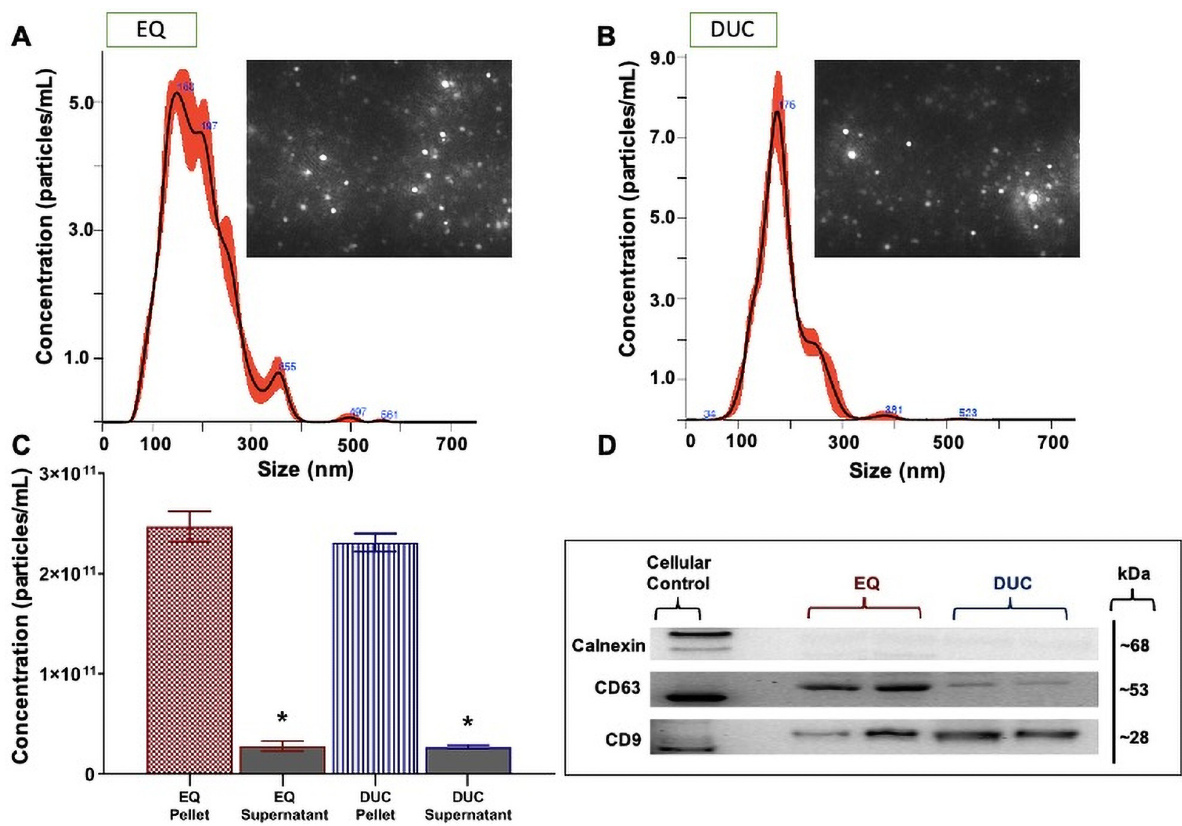
Fig 9. Human milk-derived exosomes isolated via ExoQuick (EQ) precipitation and differential ultracentrifugation (DUC) method. Size and distribution profiles of human milk-derived exosomes as determined by Nanoparticle Tracking Analysis (NTA) (A). Concentration [particles/mL] of human milk-derived exosomes (pellet fraction) (B). Relative protein abundance of two exosome-specific protein markers (CD9 and CD63) and a cellular protein marker (Calnexin) as determined by western immunoblotting in the pellet fraction (C). Total soluble protein isolated from human microglia cell culture (HMC3) is used to represent cellular total protein profiles. Data are mean ± SEM with n = 6 independent trials/group. � Significant difference in exosome concentration between the pellets and supernatants (p � 0.05). S10–S12 Figs shows the complete immunoblot images of the protein